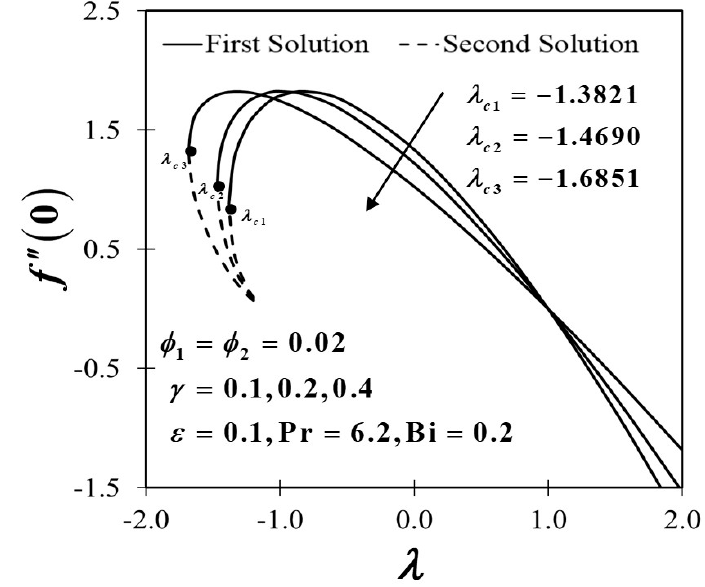
Figure 2. Variants of